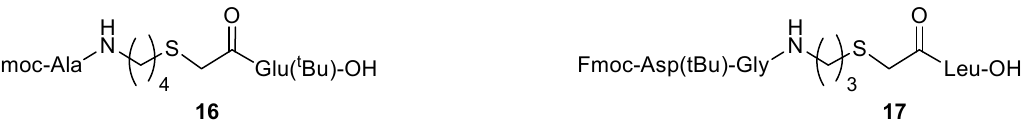
Figure 2. Structure of thioether containing peptide 16 (synthesized by using route A), and 17 (synthesized by using route B).